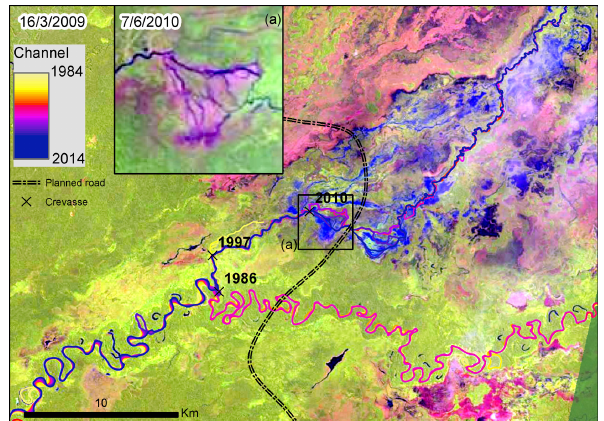
Figure 5. Avulsions of the Río Sécure. River overflow and new crevasses form large floods (bluish areas) along the annexed chan- nel. The planned road from Villa Tunari to San Ignacio will cut through this